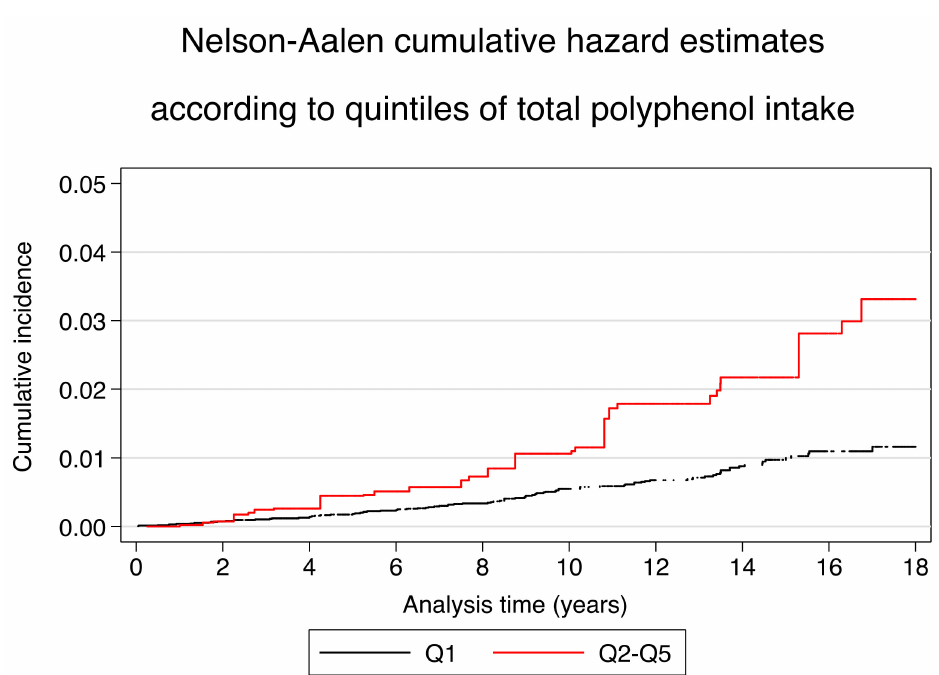
Figure 2. Nelson–Aalen cumulative hazard ratios estimates of cardiovascular disease according to low intake (Q1) vs. a medium-high (Q2–Q5) total PI. Multivariable adjusted model 1 using inverse probability weighting to adjust for sex, age, energy intake (kcal/day), smoking status (never smoker, current smoker or former smoker), lifetime tobacco exposure (packs-years), BMI (kg/m 2 ) and the quadratic term, dyslipidemia(yes/no), hypertension(yes/no), diabetes, family history of CVD (yes/no), physical activity (metabolic equivalents-h/week), TV watching (hours/day), use of cardiovascular drugs (yes/no), health consciousness (quintiles), energy-adjusted alcohol intake (g/day), and energy-adjusted sodium intake